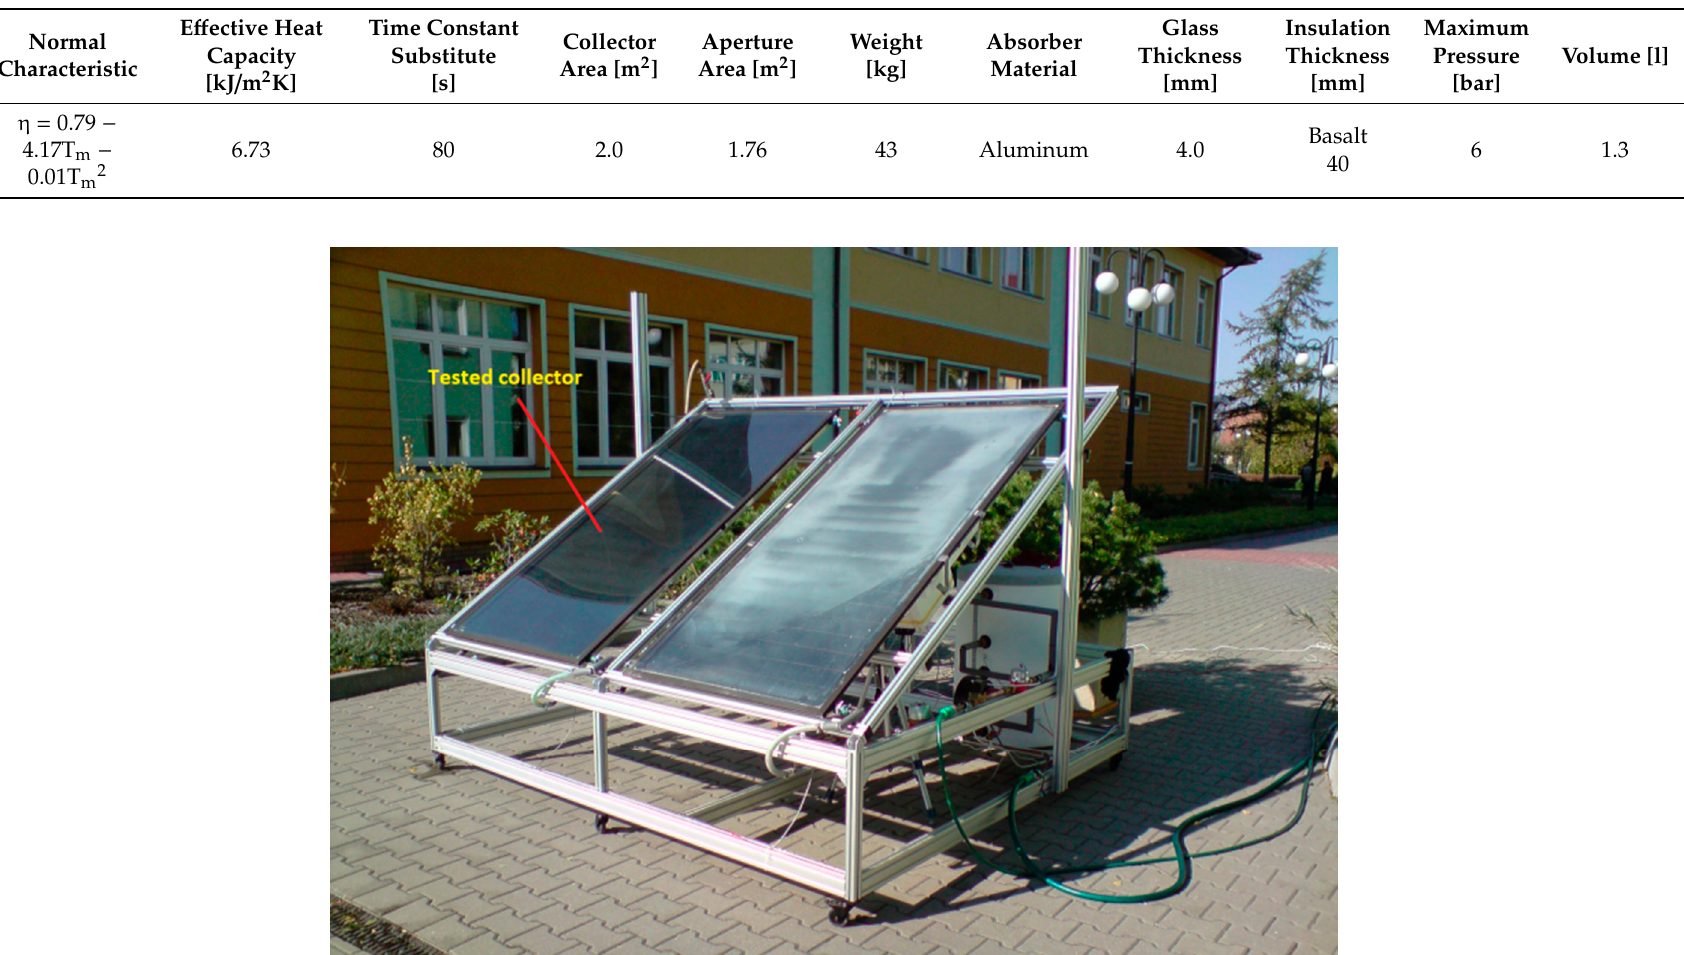
Table 2. Characteristic parameters of the tested collector according to iso 9806 indoor conditions.